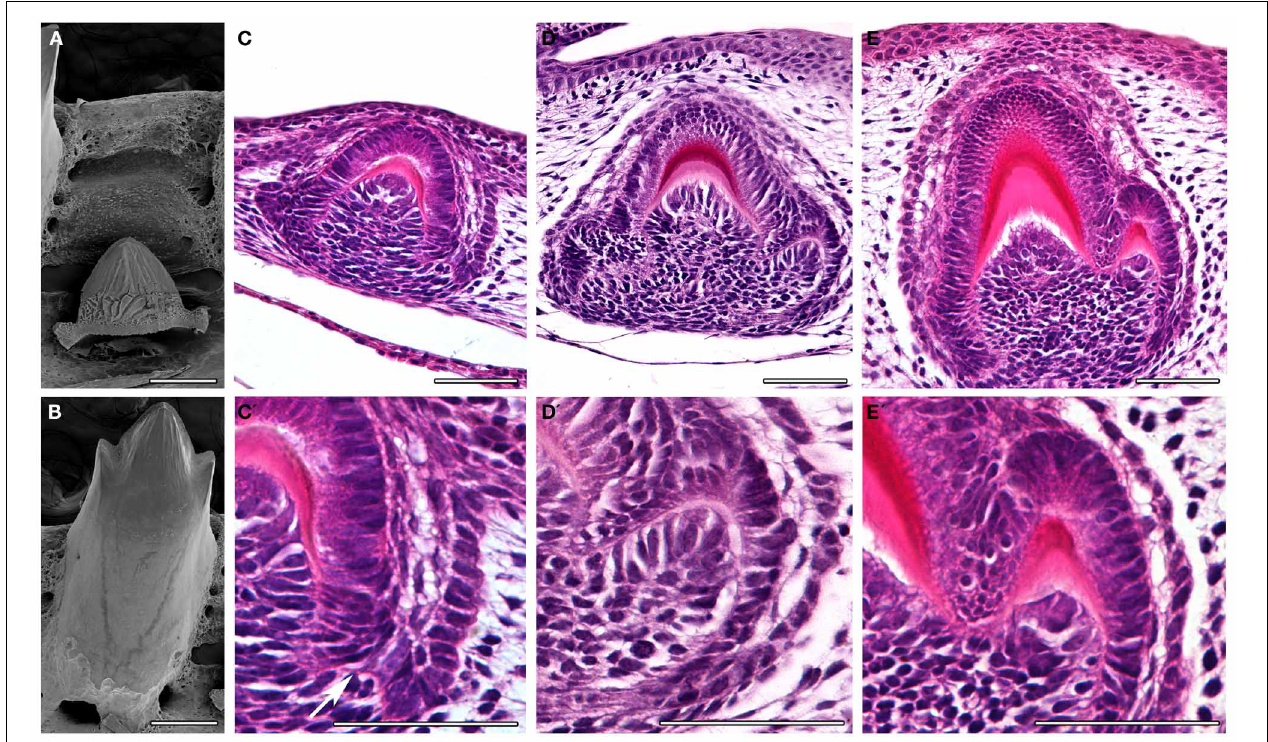
FIGURE 4 | Tooth cusp development in the anole, Anolis allisoni. (A,B) SEMs of a developing unerupted tooth (A) and a functional tooth (B) . (C–E) Sagittal sections through developing anole teeth at stage 17 and 18. (C’–E’)